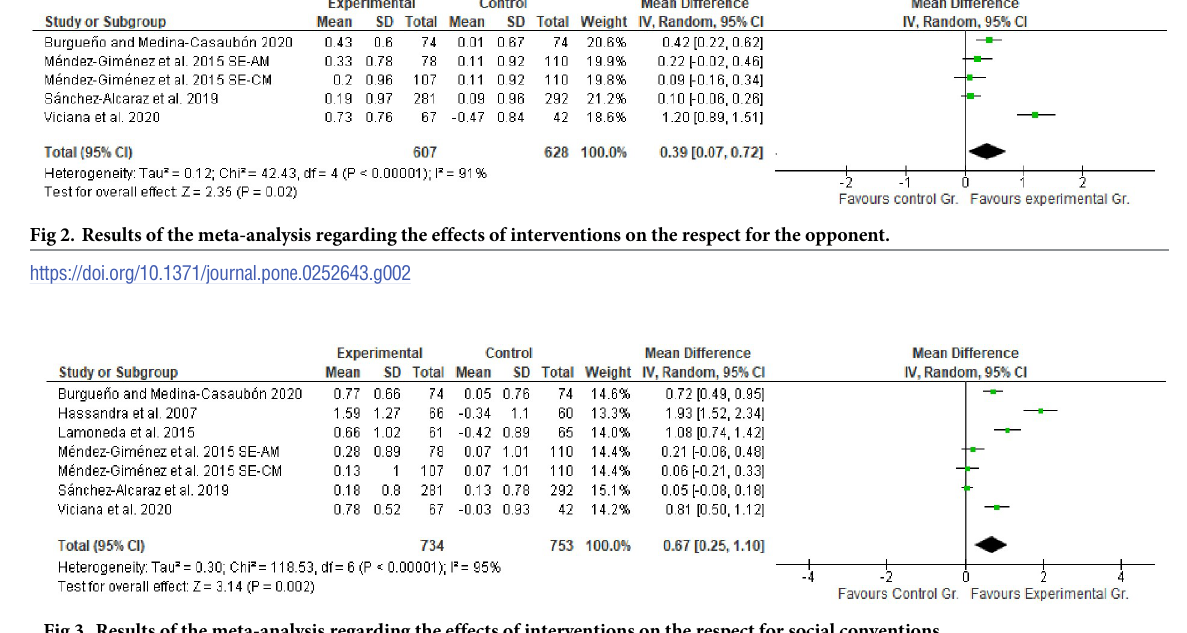
PLOS ONE | https://doi.org/10.1371/journal.pone.0252643 June 3,